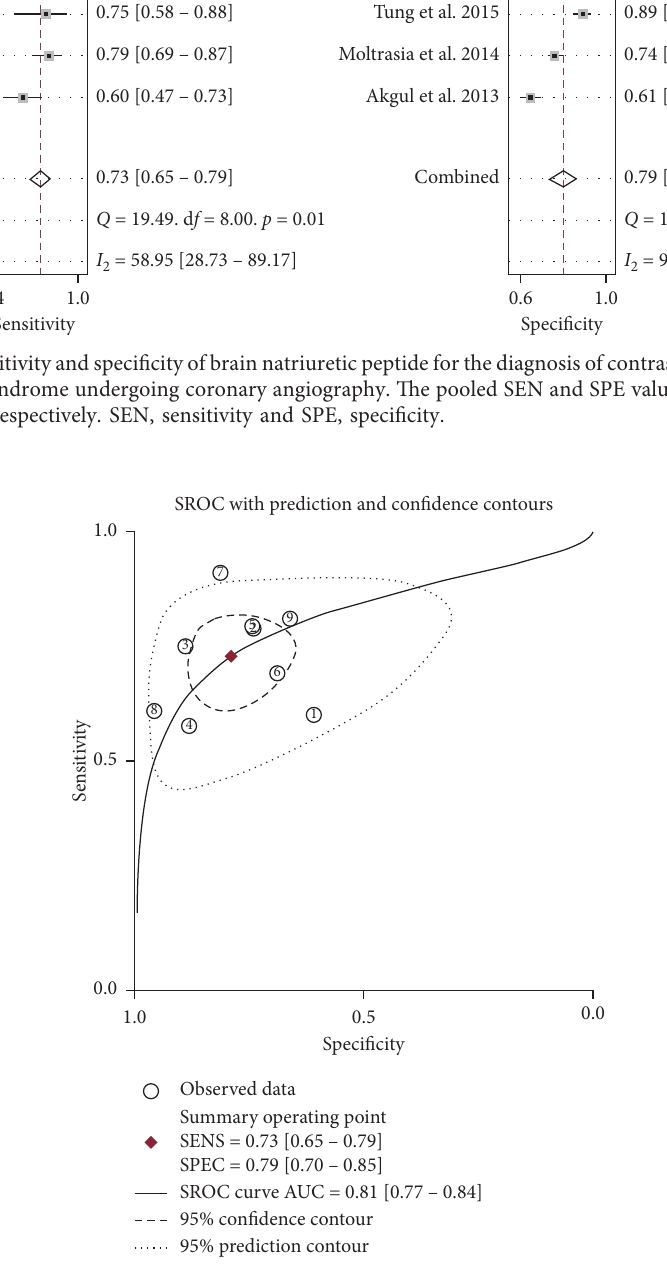
Figure 4: Summary receiver operating characteristic curve for the included studies. The AUC of brain natriuretic peptide for the diagnosis of contrast-induced acute kidney injury was 0.81 (95% CI 0.77–0.84), indicating a high diagnostic value. SROC, summary receiver operating characteristic; AUC, area under curve; SEN, sensitivity and SPE,